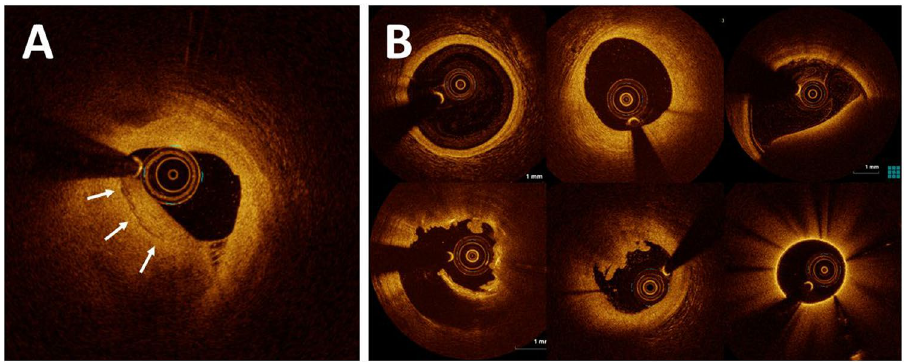
Figure 1. Representative optical coherence tomography image classes. Arrows indicates a layered pattern. OCT frames were classified into two entities: ( A ) layered plaque and ( B ) other in which layered plaque was not observed. Since the automated detection of layered plaque during an OCT pullback is preferred, OCT images also contained sections with normal vessel segment, non-layered plaques, different types of artifacts, and views of guiding